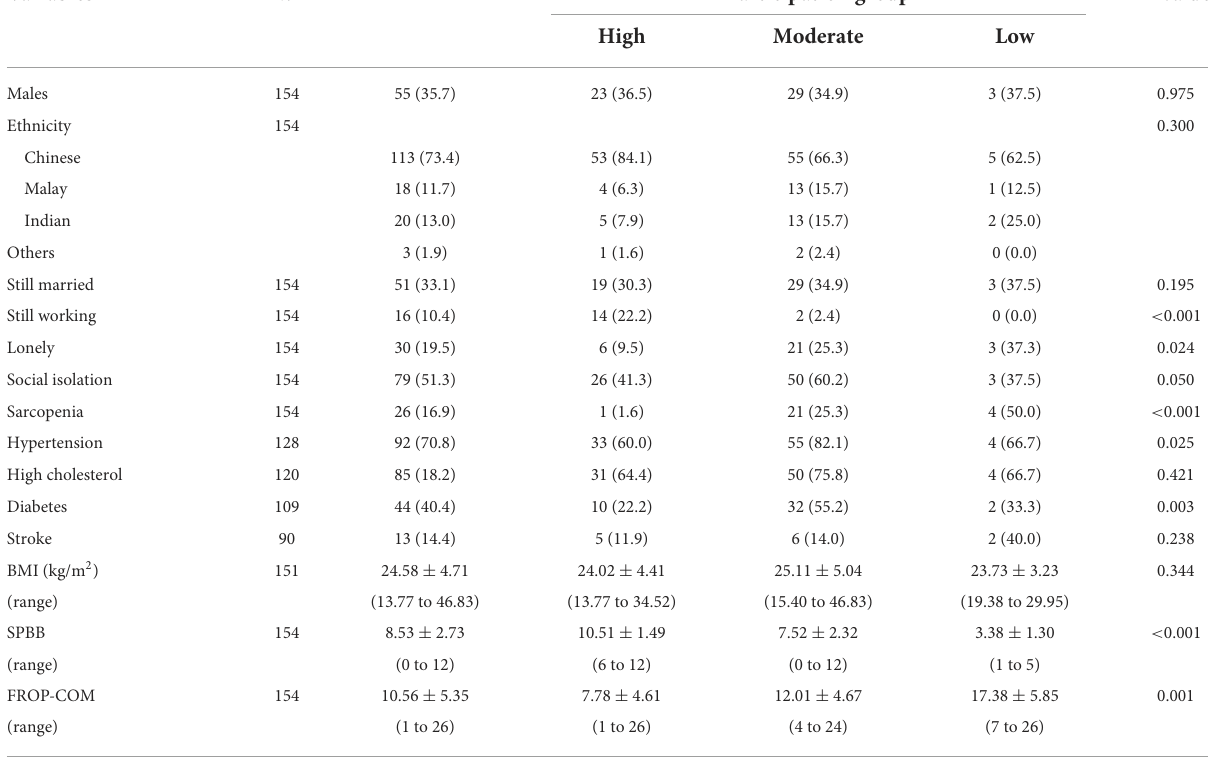
TABLE 3 Demographic co-variates by participation